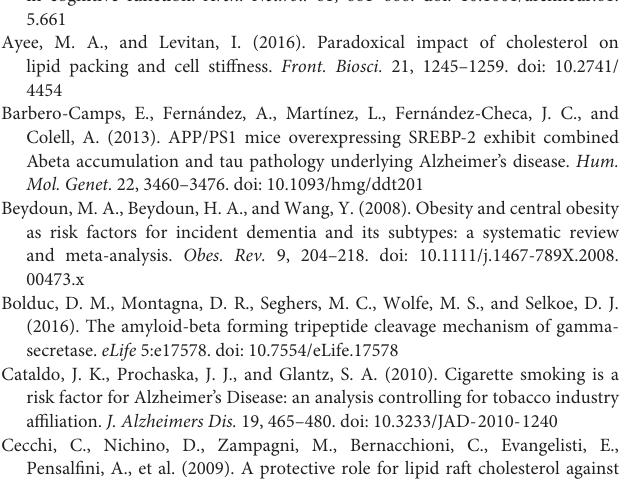
FIGURE S1 | Electron micrographs that demonstrate the presence of amyloid aggregates in the preparations used with immunogold (5 nm particle). (A) Micrographs of A β oligomers preparations showing the distribution of different size oligomers. (B) Zoom of the section shown in A , demonstrating the presence of spherical or disc shaped oligomeric species. FIGURE S2 | GP image analysis workflow. Representative scheme showing the different steps for the quantification of GP values (GP total, GP1, and GP2) in the cellular membrane. First, channel one (Ch1) is used to create the mask (taking the first 5 pixels from outside of the cell to the inside). After this, the mask is applied in the GP image obtaining the GP image for the cell membrane. From this image, we obtain the histogram and from that we obtain the GP total, GP1, and GP2. The percentage of coverage of GP1 and GP2 was calculated and expressed as “Area of GP”. FIGURE S3 | Effects of M β CD and water-soluble cholesterol in HEK-293 cells. (A) Quantification of Filipin III fluorescence indicating the relative cholesterol levels after treatment with M β CD (3 mM) and cholesterol/ M β CD complex (200 µ M cholesterol) in HEK-293 cells (B) . The graphs show the effectiveness of the treatment to increase or decrease membrane cholesterol levels in this cell line. The bars represent the average ± SEM. ∗ Denotes p < 0.05 and ∗∗∗ p <